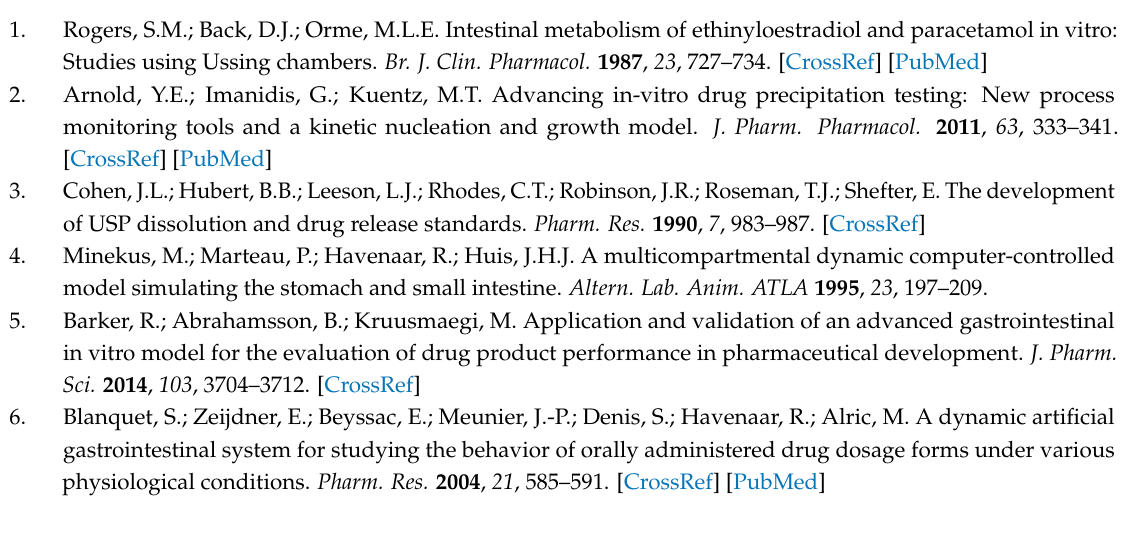
Table S1: UHPLC-MS/MS methods, Table S2: Precision and accuracy of the analytical